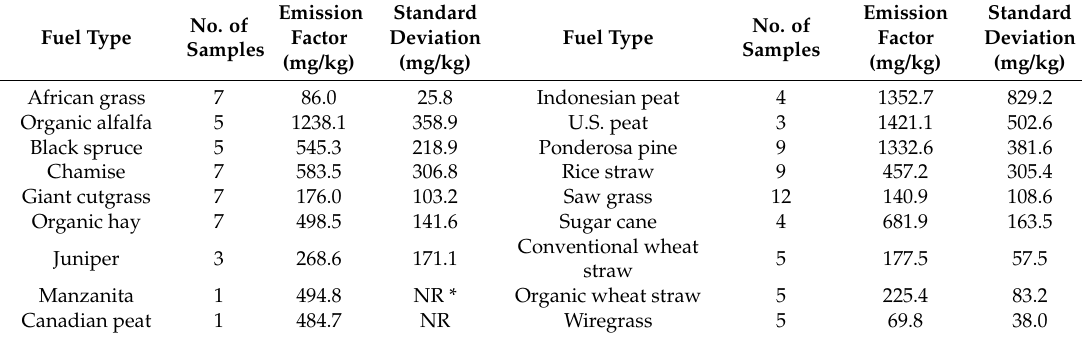
Table 2. Laboratory measurement of propylene emission factors for different types of biomass